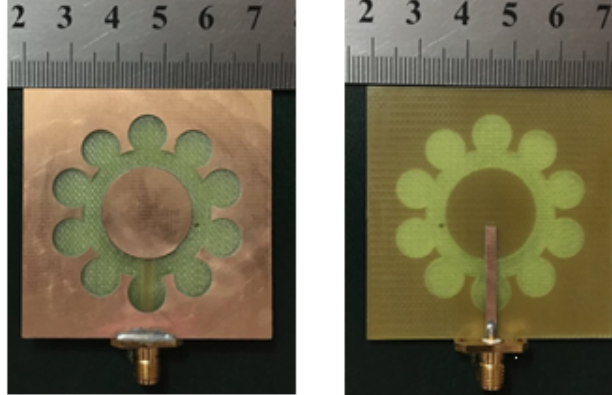
Figure 8: Photograph of the fabricated antenna with SMA.